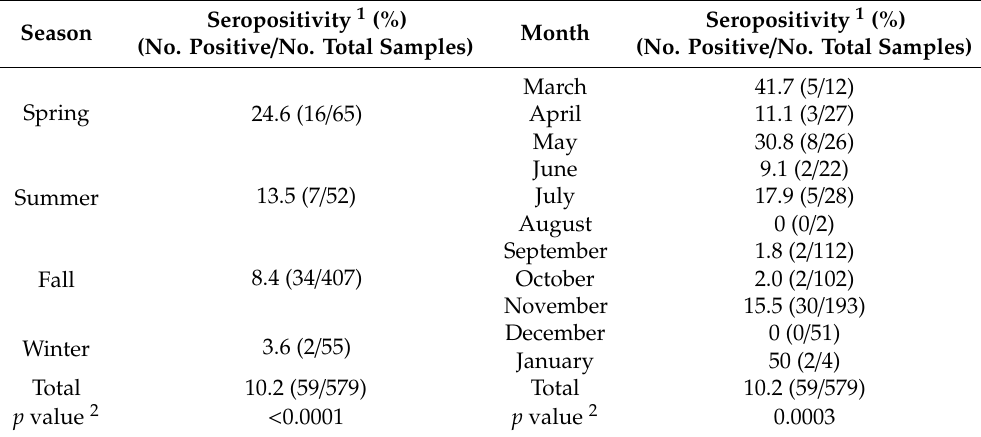
Table 1. Seasonal and monthly seropositive rates against rabies virus in wild boars ( Sus scrofa ) in